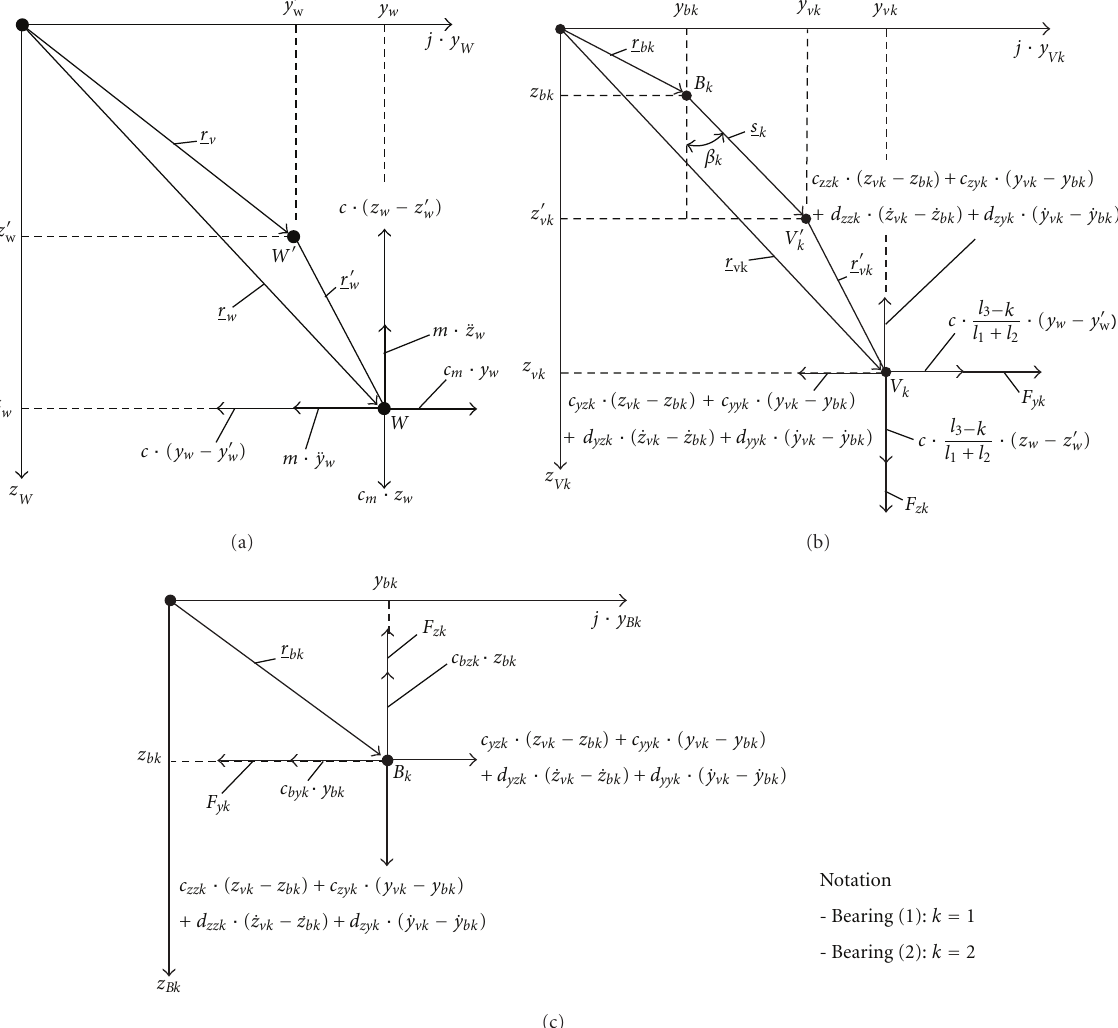
Figure 5: Vibration model, split up into subsystems: (a) rotor mass system, (b) shaft journal system, (c) bearing housing system.